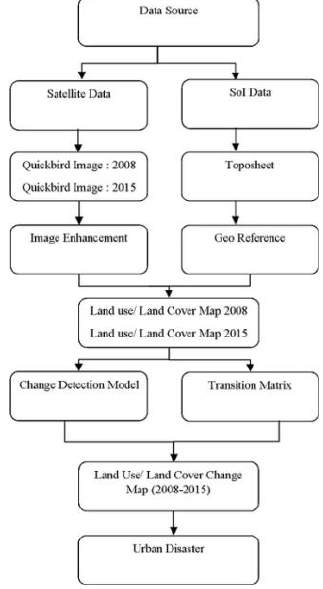
Figure 2: Flow Chart of